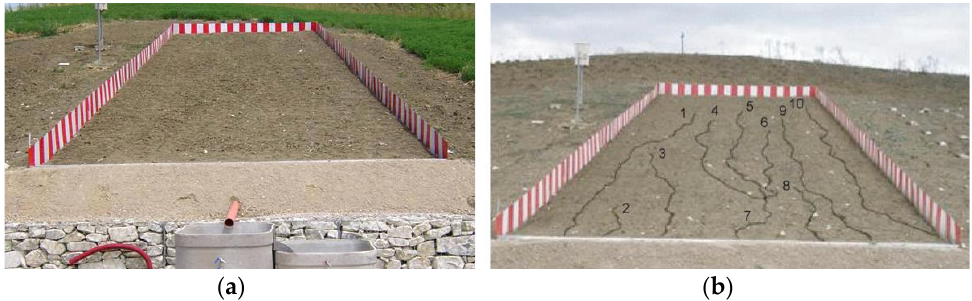
Figure 12. View of the plot ( a ) before and ( b ) after rill network formation. Rill channels are numbered from 1 to 10 (modified from [61]).